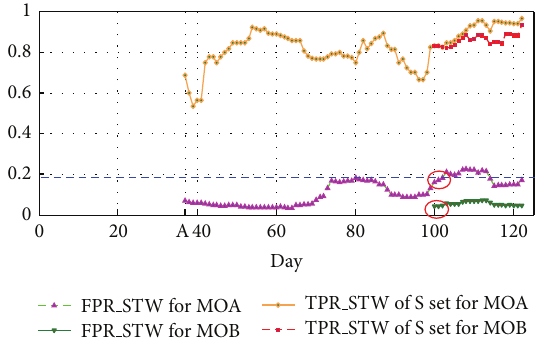
Figure 7: Callout rate in a sliding window of 15 days before and after the update of the reference model image set.